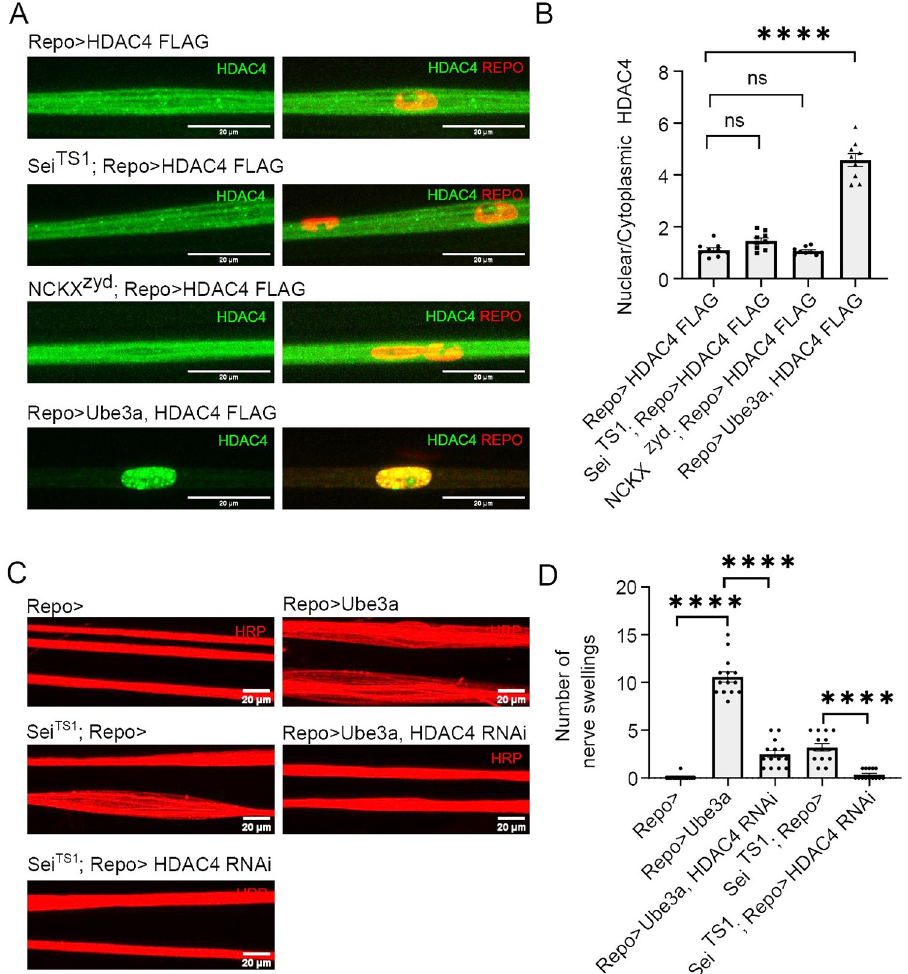
Fig 1. Hyperexcitability influences glial K + buffering program. (A) Representative images of larval peripheral nerves demonstrating the effects of seizure mutants on HDAC4 localization in glia. Pan glial driver, Repo-Gal4, was used to express a FLAG-tagged HDAC4 (green). Glial nuclei are stained with Repo (red). Scale bars 20 μ m. (B) Quantification of nucleo:cytoplasmic ratio of HDAC4 for genotypes in (A). Data are represented as fold changes relative to Repo > HDAC4 . n � 6. Each data point represents one larvae in which 4–5 nerves were assessed. Statistical significance was determined by one-way ANOVA with Dunnett’s multiple comparisons test; NS = not significant, ���� , p < 0.0001. Data are mean ± SEM. (C) Representative images of larval peripheral nerves stained for the nerve membrane marker HRP. Repo-Gal4, a pan glial driver, was used to express LexA RNAi (Repo > ) or HDAC4 RNAi in both hyperexcitability mutants. (D) Quantification of nerve swellings for genotypes in (C). n � 15. Statistical significance was determined by one-way ANOVA with Sˇı´da´k’s multiple comparisons; ���� , p < 0.0001. HDAC4 knockdown suppressed nerve swellings compared to seizure mutants expressing control transgene, UAS-LexA